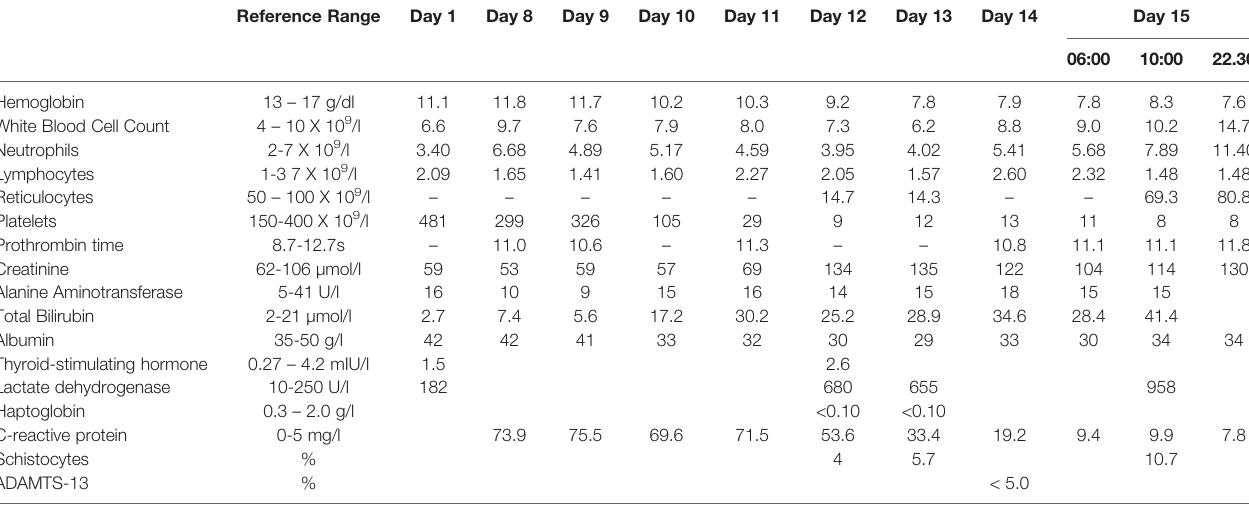
TABLE 1 | Patient case – daily laboratory parameters consistent with evolving TTP following cycle 1 of ipilimumab and nivolumab. Reference Range